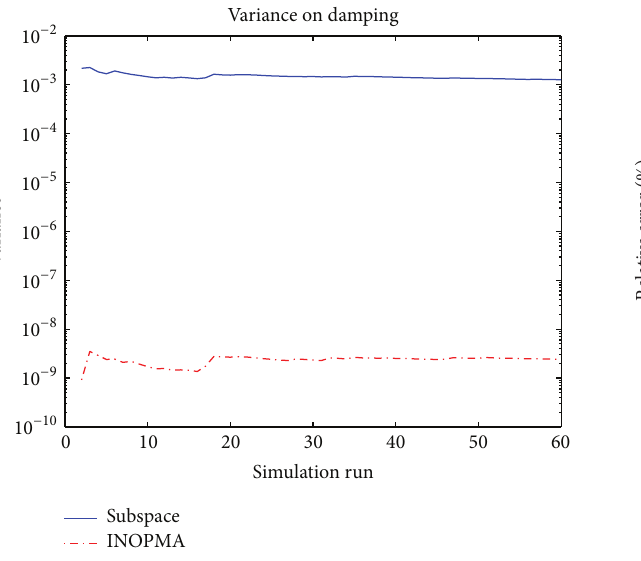
Figure 3: Absolute value of the relative error on the frequency.